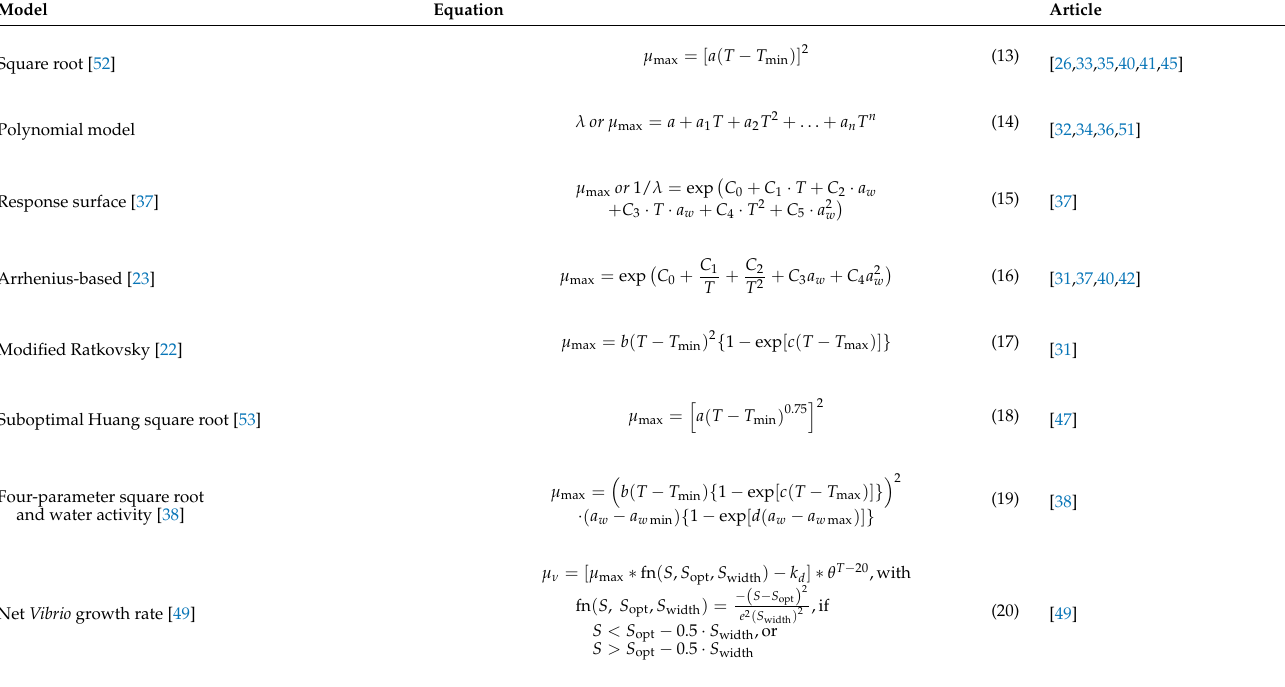
Table 2. Systematized equations for Vibrio spp. secondary growth models. These models modify specific growth rate and lag time in primary models to capture effects of environmental conditions such as temperature, salinity, and pH.